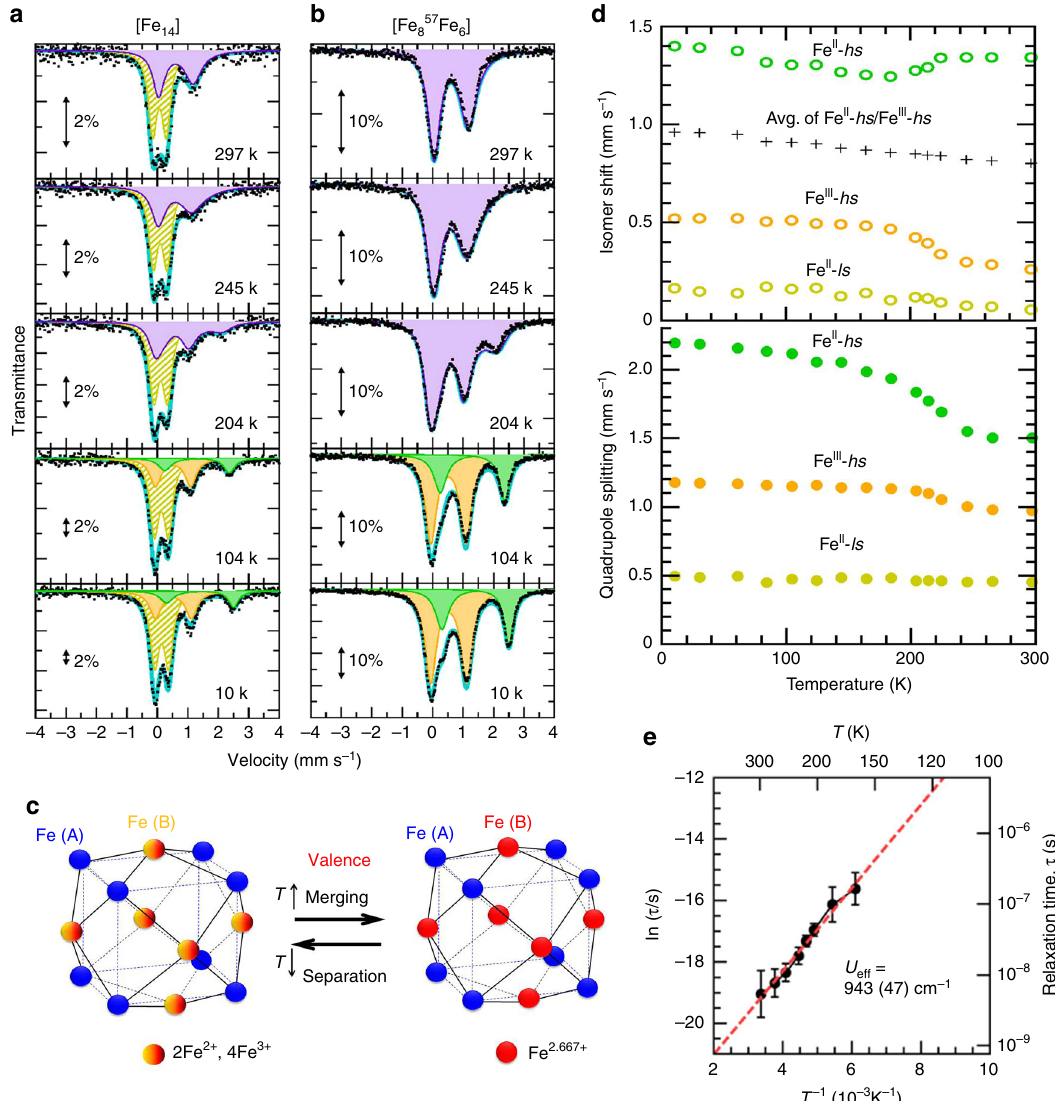
Fig. 2 Mössbauer spectra analysis of the valence and spin state of the Fe ions. a – b Zero- fi eld 57 Fe Mössbauer spectra of a natural isotopic [Fe 14 ] and a fi ts considering the electron hopping between Fe II -hs and Fe III -hs 57 Fe-enriched sample on the N-terminal B site, [Fe 57 Fe 8 6 ], at selected temperatures with (purple area), Fe II -hs (green area), Fe III -hs (orange area), and Fe II -ls (striped yellow area). c Schematic of the valence behavior on the crystallographically equivalent B site in the Mössbauer time window. d Quadrupole splitting (QS) and isomer shift (IS) as a function of the temperature in the Mössbauer spectra. The values of Fe II -hs (green) and Fe III -hs (orange) are determined from the 57 Fe-enriched sample, whereas those of Fe II -ls (striped yellow area) are determined from the natural sample. e Temperature dependence of the relaxation time ( τ ) of the electron hopping between Fe III -hs and Fe II -hs in the temperature window of 164 – 297 K. The error bars were estimated as the respective deviations having the deference of the reduced chi-square value ( Δ χ 2 ) within 2, considering the parameter correlations in the fi tting. The red line represents the Arrhenius fi tting in the high-temperature